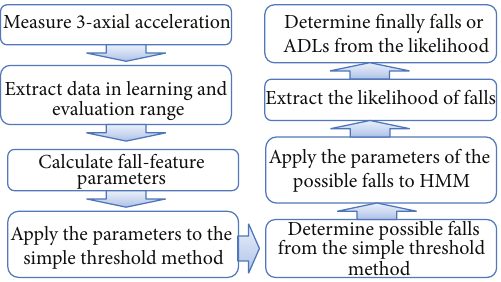
Figure 2: Flow diagram for falls detection